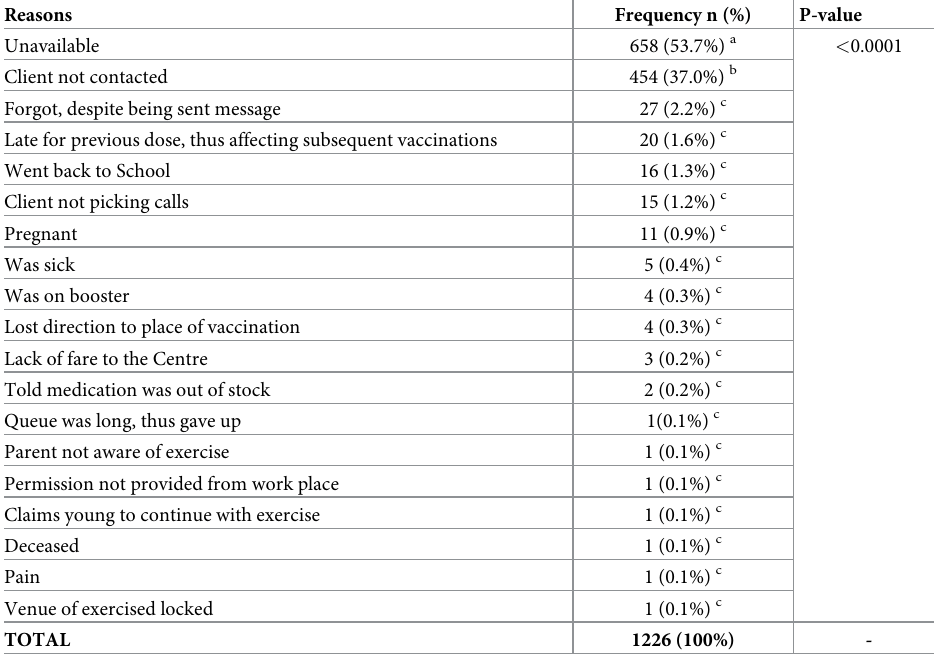
Table 3. Reasons for incomplete HBV vaccination among outpatient clinic attendees in Kenya in 2015. Reasons Frequency n (%) P-value Unavailable 658 (53.7%) a < 0.0001 Client not contacted 454 (37.0%) b Forgot, despite being sent message 27 (2.2%) c Late for previous dose, thus affecting subsequent vaccinations 20 (1.6%) c Went back to School 16 (1.3%) c Client not picking calls 15 (1.2%) c Pregnant 11 (0.9%) c Was sick 5 (0.4%) c Was on booster 4 (0.3%) c Lost direction to place of vaccination 4 (0.3%) c Lack of fare to the Centre 3 (0.2%) c Told medication was out of stock 2 (0.2%) c Queue was long, thus gave up 1(0.1%) c Parent not aware of exercise 1 (0.1%) c Permission not provided from work place 1 (0.1%) c Claims young to continue with exercise 1 (0.1%) c Deceased 1 (0.1%) c Pain 1 (0.1%) c Venue of exercised locked 1 (0.1%) c TOTAL 1226 (100%) - Different letter superscripts ( a, b, and c ) indicate that the values in each of the reasons raised by participants differ